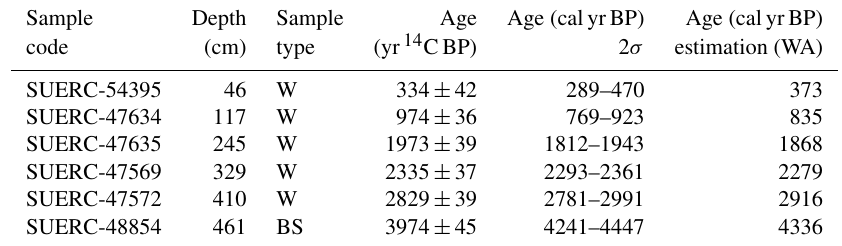
Table 2. AMS radiocarbon dates used for the age–depth model of Lake Pindo. SUERC: lab code (from NERC Radiocarbon Facility, East Kilbride); BS: bulk sediment; W: wood; WA: weighted